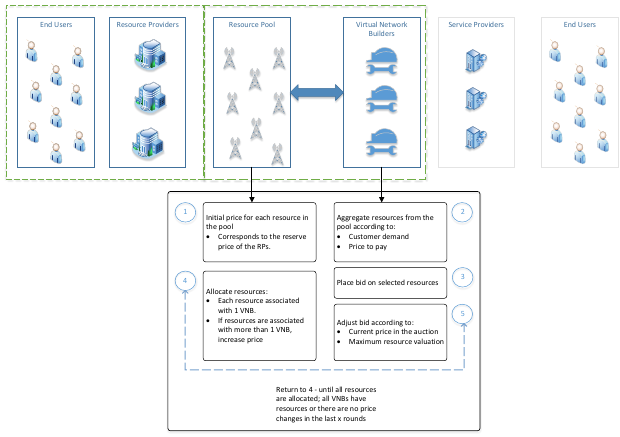
Figure 7. VNBs’ interactions with the pool to aggregate resources and gain